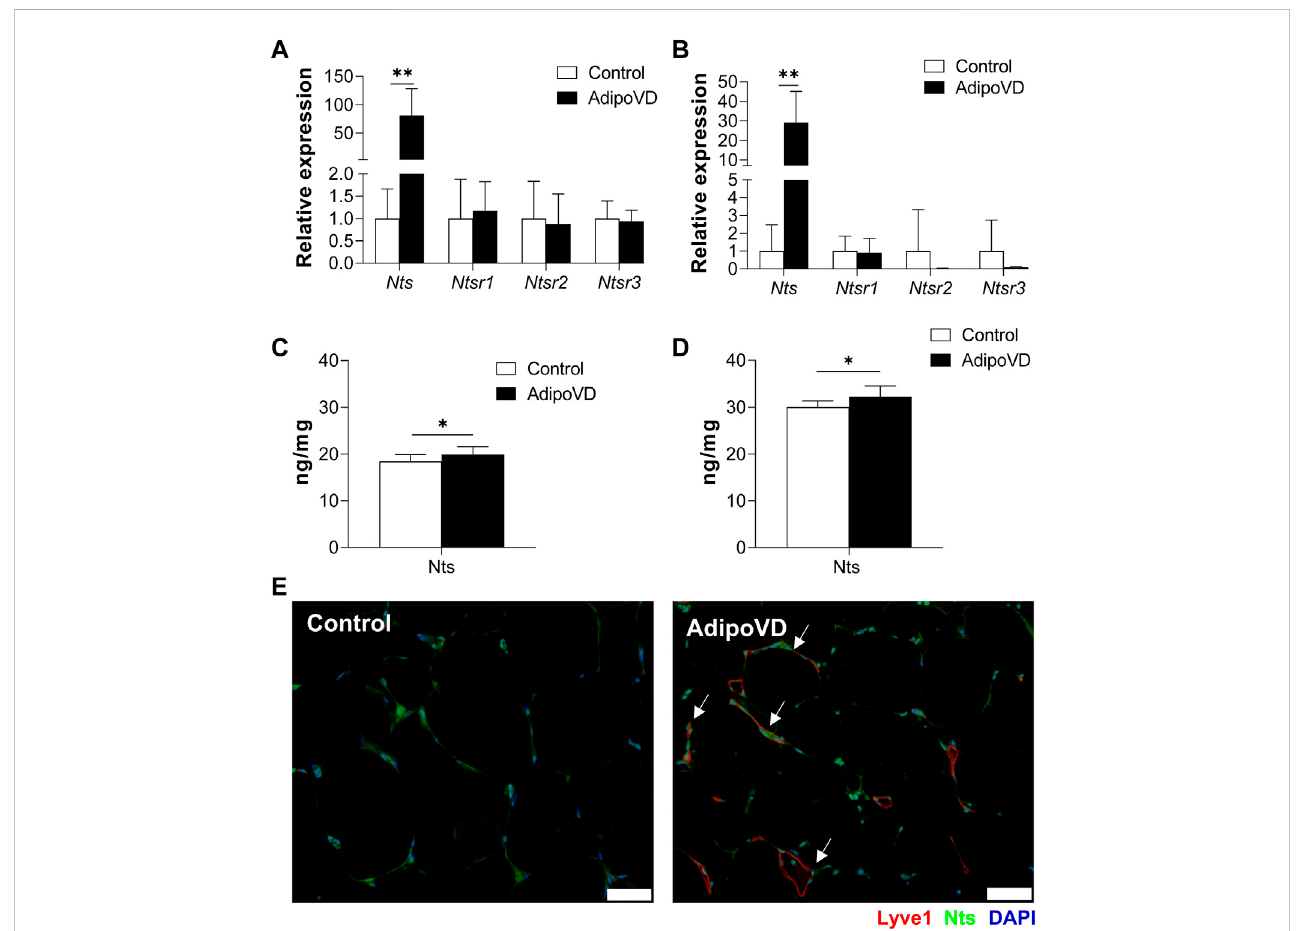
FIGURE 2 LymphangiogenesisinAdipoVDmiceresultinincreasedneurotensinproduction. (A) Neurotensin andneurotensinreceptorrelativemRNAexpressionin BAT of AdipoVD mice compared to Controls. (B) Neurotensin and neurotensin receptor relative mRNA expression in SQAT of AdipoVD mice compared to Controls. (C) ELISA quanti fi cation of neurotensin concentrations from BAT normalized to tissue protein levels. (D) ELISA quanti fi cation of neurotensin concentrations from SQAT normalized to tissue protein levels. (E) Immuno fl uorescence of neurotensin (green; Nts) and lymphatics (red; LYVE-1) in the BAT depot from Control and AdipoVD mice on HFD. (A – E) n = 10 control/ n = 7 AdipoVD. Bars = 50